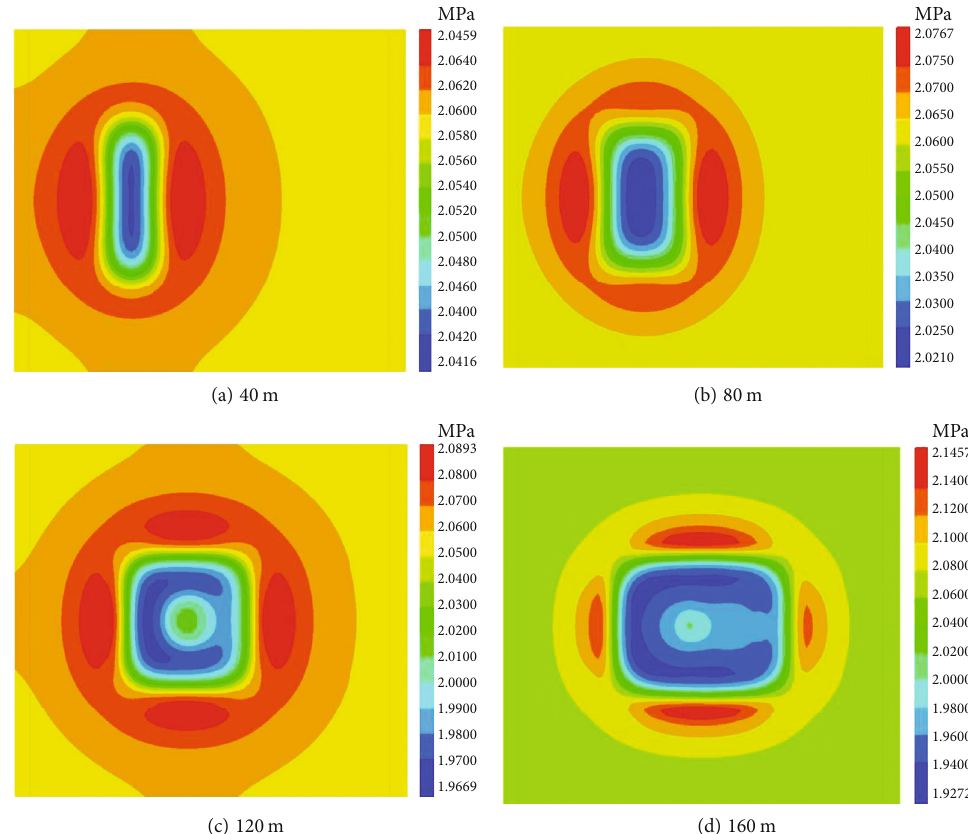
Figure 13: Gas pressure evolutions of protected layer at di ff erent advancing distances.